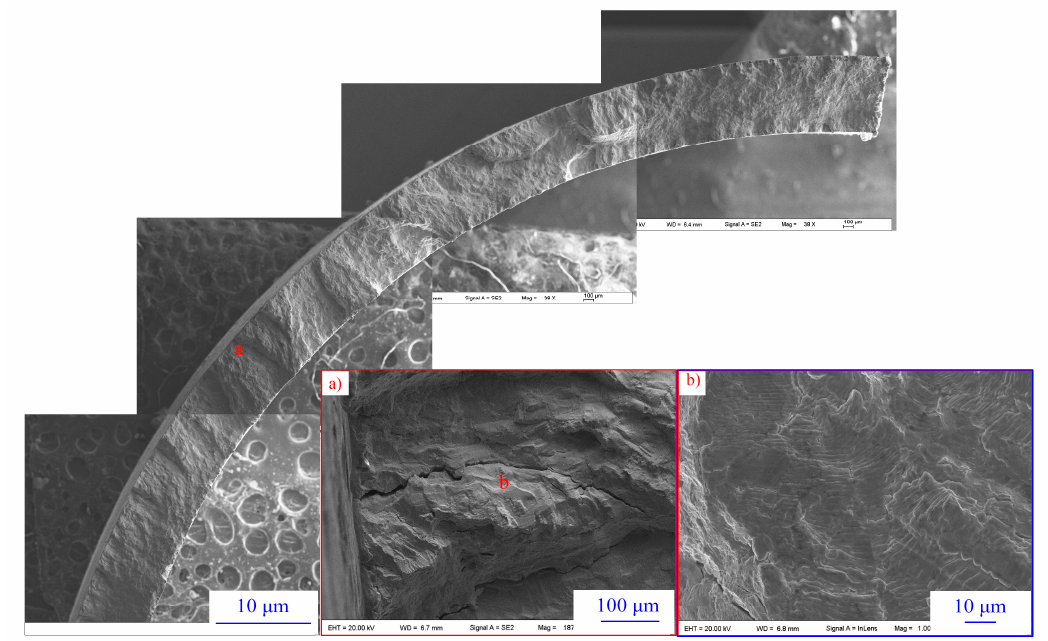
Figure 10. Typical morphologies of surface cracks on SG tube specimens after fatigue tests.